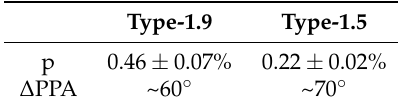
Table 1. Preliminary values of the polarization parameters on ESO 362-G18 for both exhibited looks in the optical